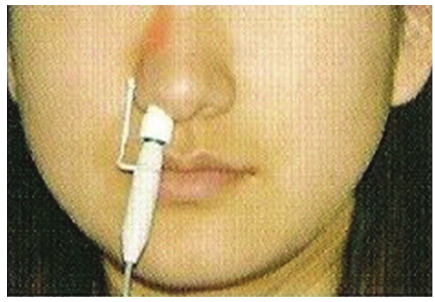
Figure 1: The setup of ILGLT at 650 nm and 8.38 mW/cm 2